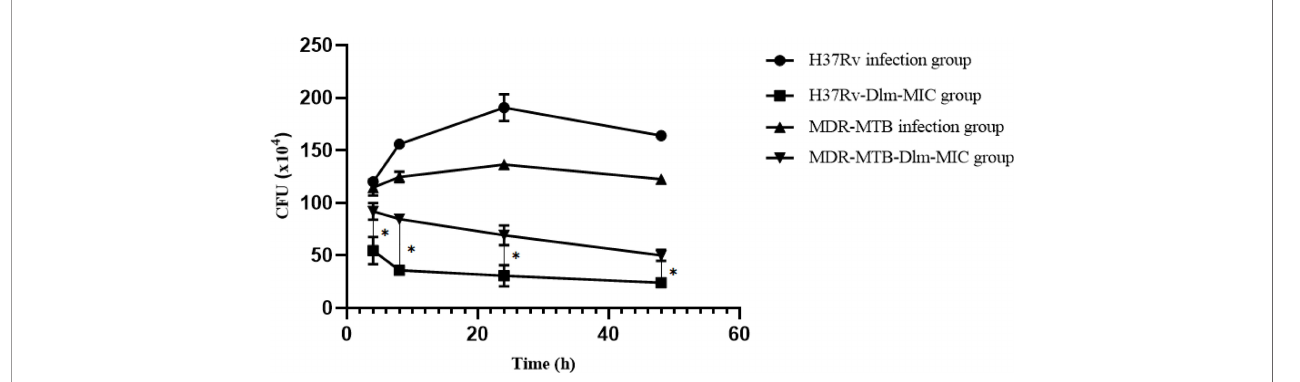
Table 2 , the level of IL-12/23 p40 of H37Rv and MDR-MTB group didn ’ t change before and after Dlm administration for